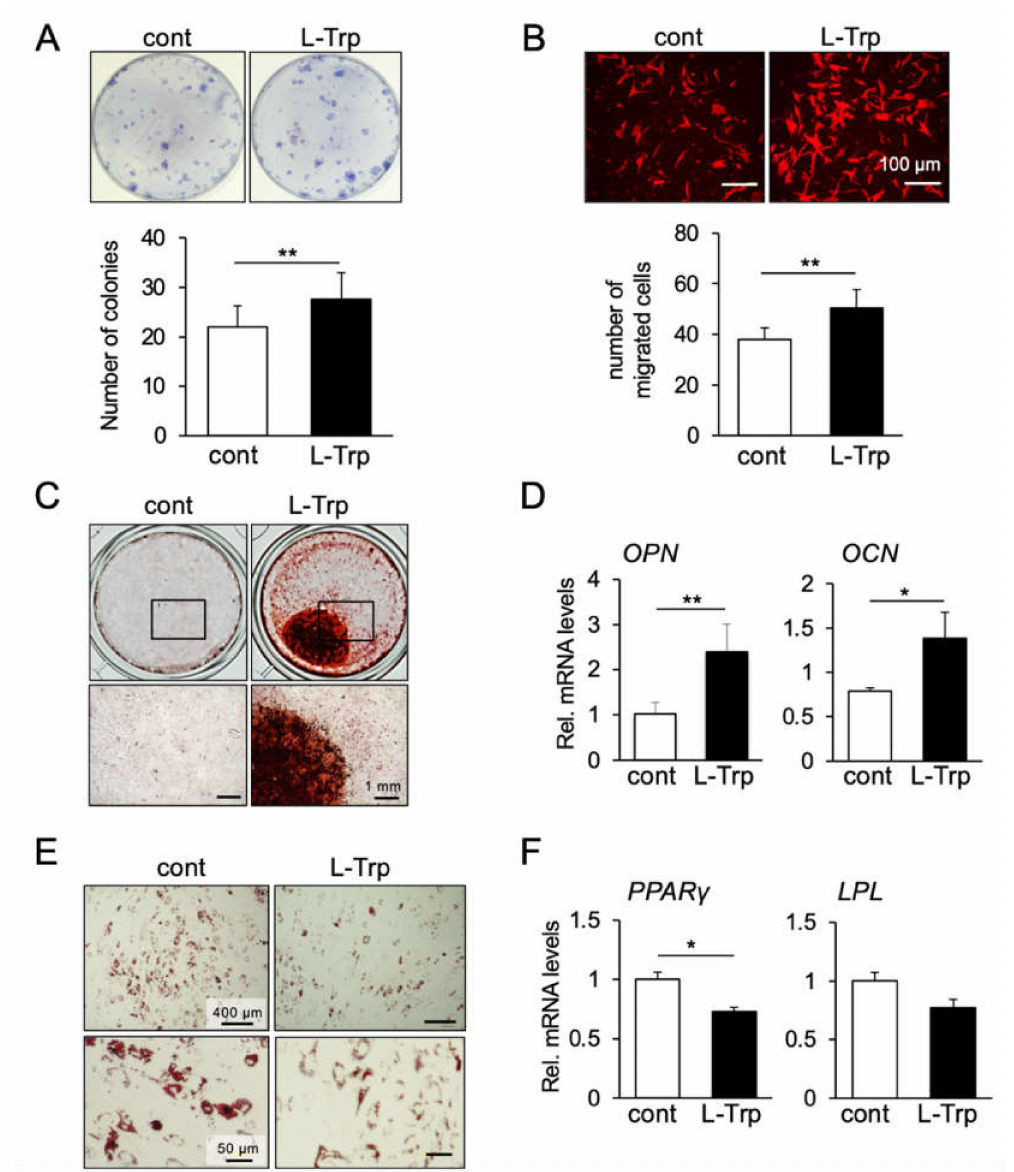
Figure 2. Effect of L-tryptophan on the stemness-related function and differentiation capability of hBMSCs in vitro. ( A ) CFU-F assay was performed using primary mBMSCs. The colony-forming potential was increased by the treatment of L-Trp. Data represent the means ± SD (n = 3). ** p < 0.01, unpaired t-test. ( B ) L-Trp induced higher migration ability compared to the control group. The images are representatives of three independent experiments. Graph shows the average number of migrated cells counted in four different pictures taken at each chamber. ** p < 0.01, unpaired t-test. Pre-treatment of L-Trp induced osteogenic differentiation of hBMSCs ( C , D ). L-Trp decreased the adipogenic ability of hBMSCs ( E , F ). * p < 0.05, ** p < 0.01, unpaired t-test. Images and graphs are representatives of at least three independent